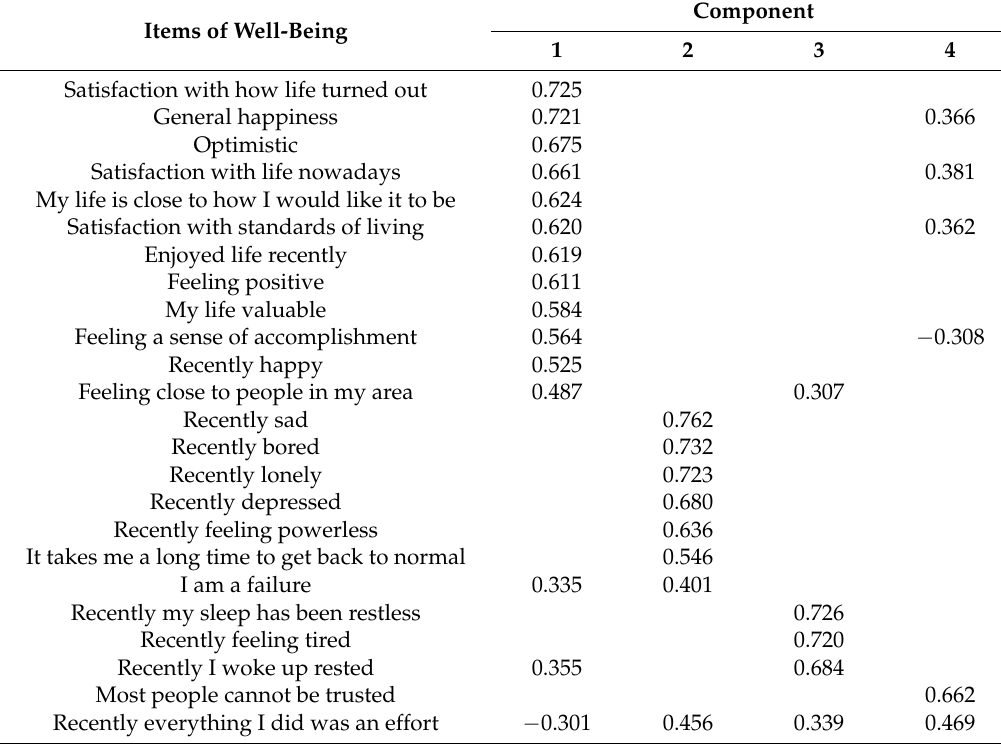
Table 2. Pattern matrix of four-component principal component analysis (PCA) solution with oblique rotation of 24 well-being